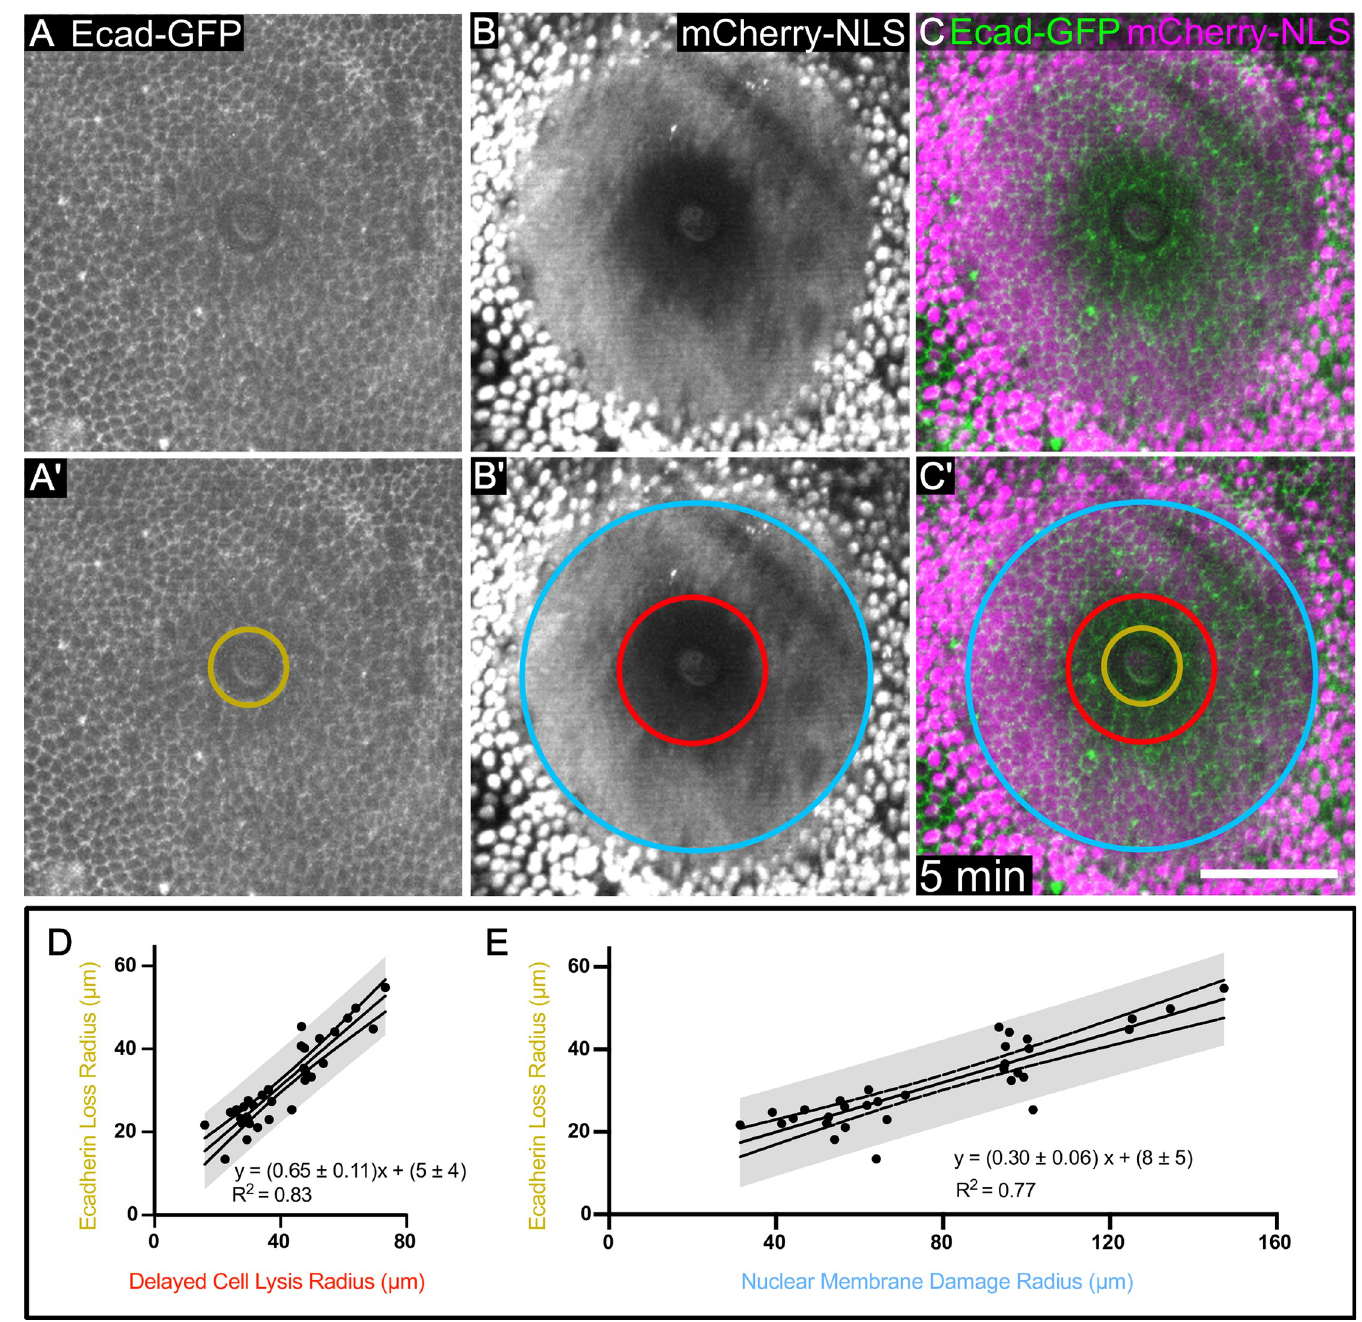
Fig 4. Cell borders are disrupted following wounding. (A) Genetically encoded Ecadherin-GFP marks cell borders and reveals damage around a pulsed-laser wound. The region of immediate Ecadherin-GFP loss is indicated with a gold circle in A’. (B,C) The region of immediate Ecadherin loss is distinct from and within the regions of delayed cell lysis (red circle) and nuclear membrane damage (blue circle). (D) The relationship of the radius of delayed cell lysis to the radius of immediate Ecadherin loss is linear. (E) The relationship of the radius of nuclear membrane damage to the radius of immediate Ecadherin-loss is linear. 95% prediction interval is indicated in D,E. n = 32 pupae. Scale bar = 50 μ